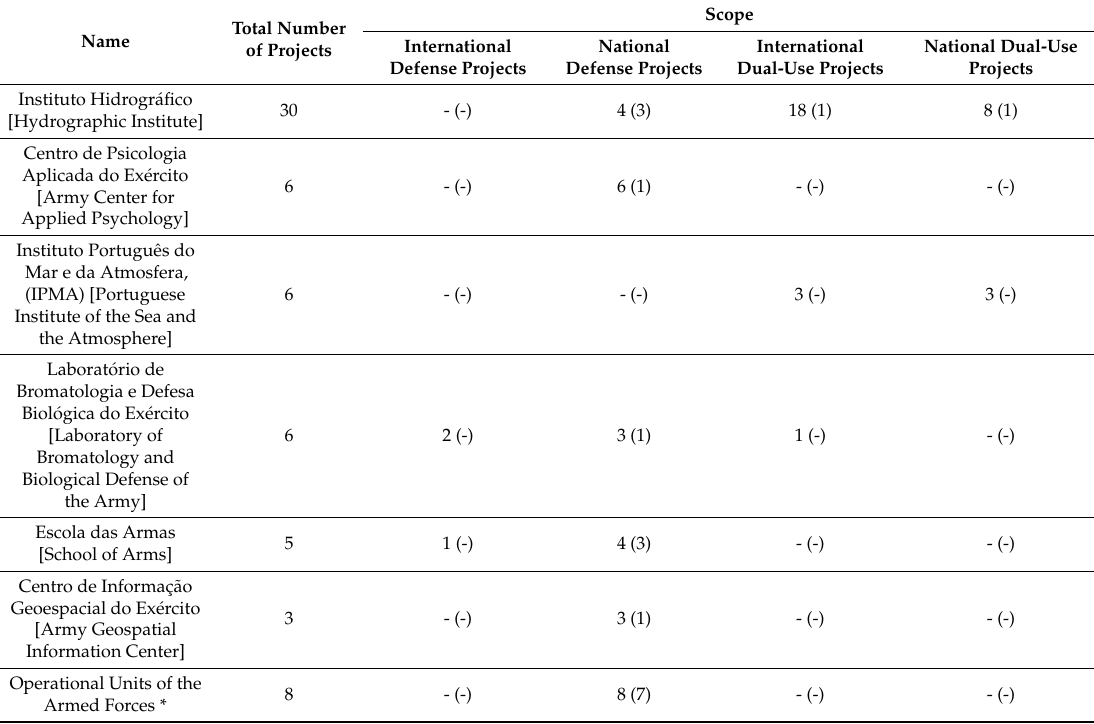
Table 5. Projects involving Portuguese entities that belong to the government